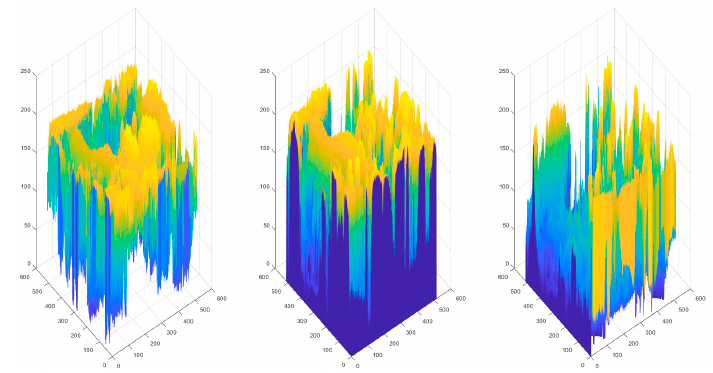
Figure 2. The distribution of color intensities in R , G , and B .